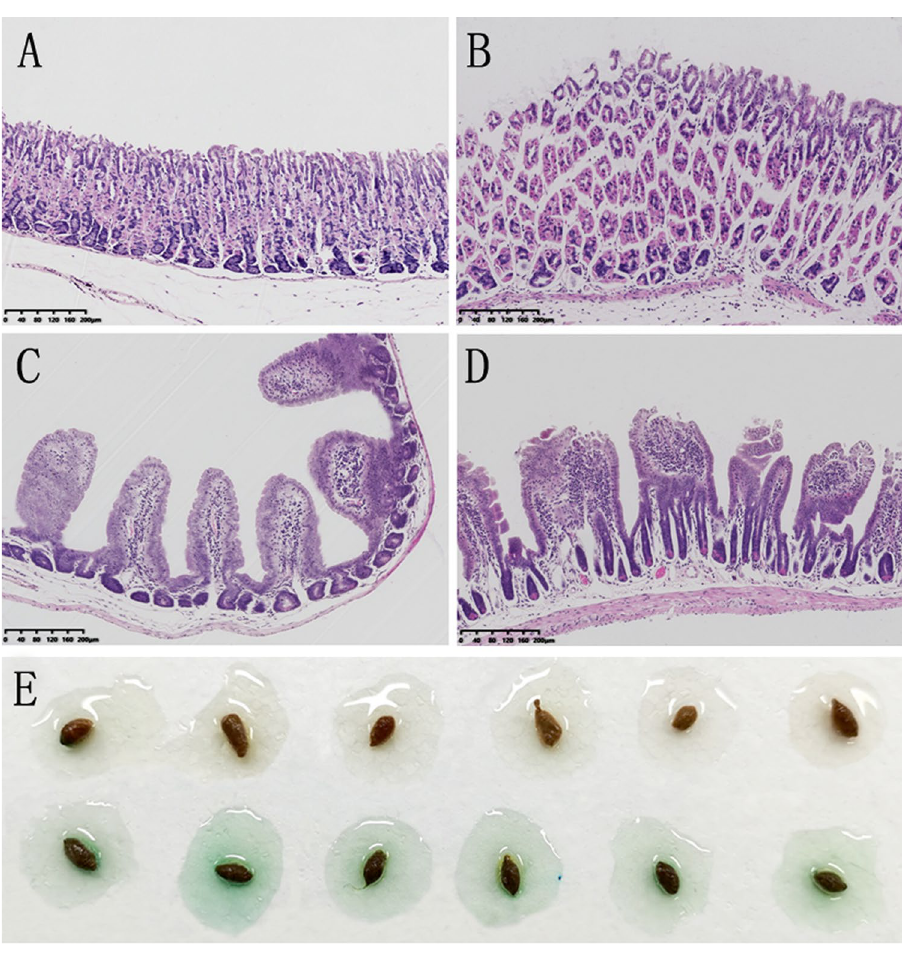
Figure 2. HE staining of duodenum and stomach: ( A ) Duodenum of Pre- FES (×10), ( B ) Duodenum of After- FES (×10), ( C ) Stomach of Pre- FES (× 10), ( D ) Stomach of After- FES (×10), ( E ) Fecal occult blood test.